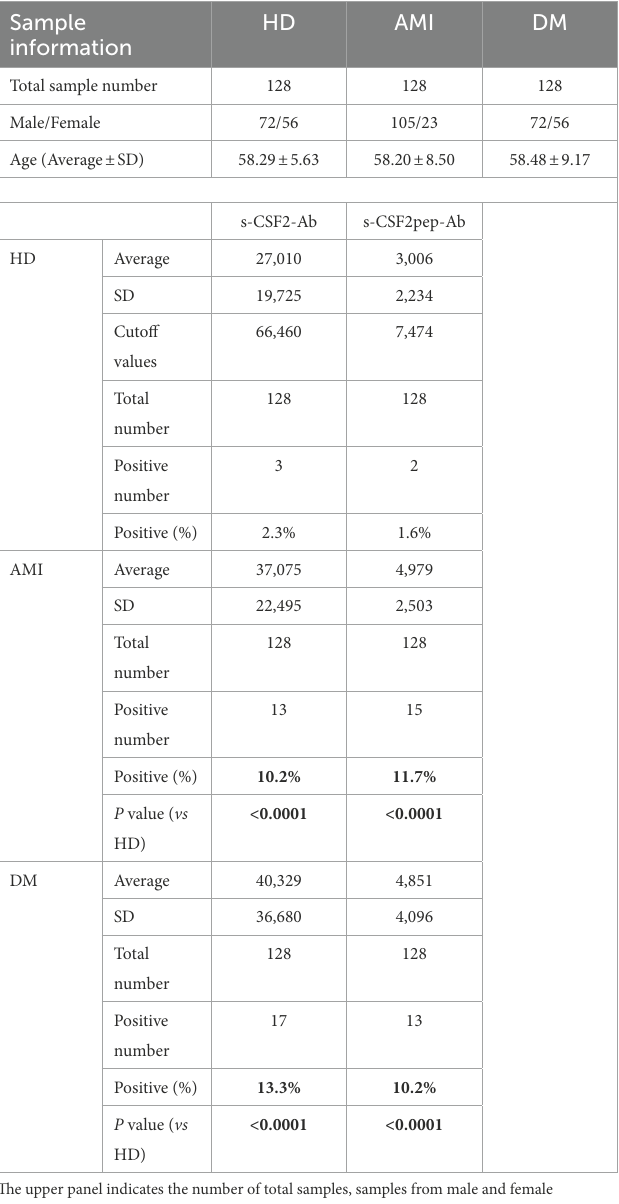
TABLE 2 Comparing the s-CSF2-Ab and s-CSF2pep-Ab levels between HDs and patients with AMI or DM. Sample information